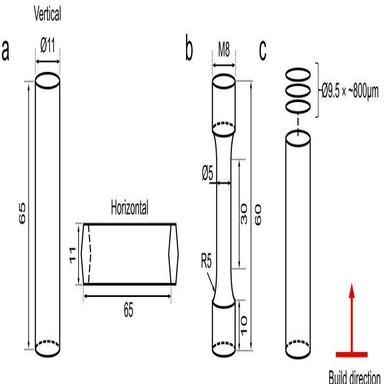
Schematic of LPBF as-built and manufactured test specimen dimensions: (a) vertical specimens were built as cylinders and horizontal specimens built as hexagonal prisms, (b) uniaxial tensile test specimens manufactured from the heat-treated condition for both orientations and (c) discs sectioned from the top of vertically built cylinders from both as-built and heat-treated condition ahead of final preparation into small punch test specimens (Ø9.5 mm, 500 ± 5 μm). All dimensions in mm.